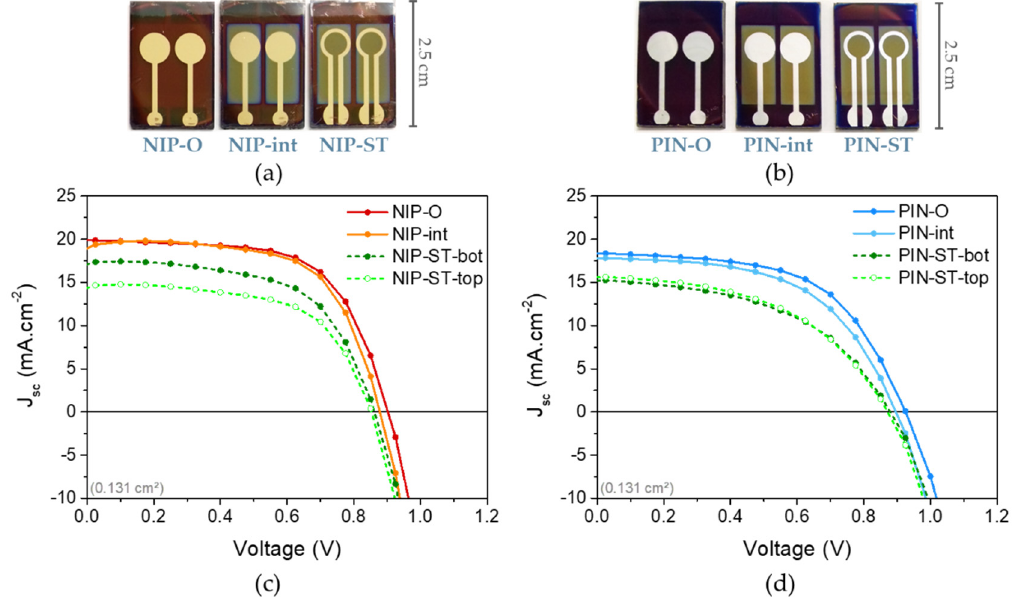
Figure 4. Pictures of ( a ) NIP- and ( b ) PIN-type perovskite devices in the three different configurations for both architectures—opaque, intermediate and semi-transparent cells (from left to right)—and ( c , d ) their respective J–V curves (“-bot” and “-top” abbreviations stand for an illumination from glass and an illumination from a metal contact, respectively).